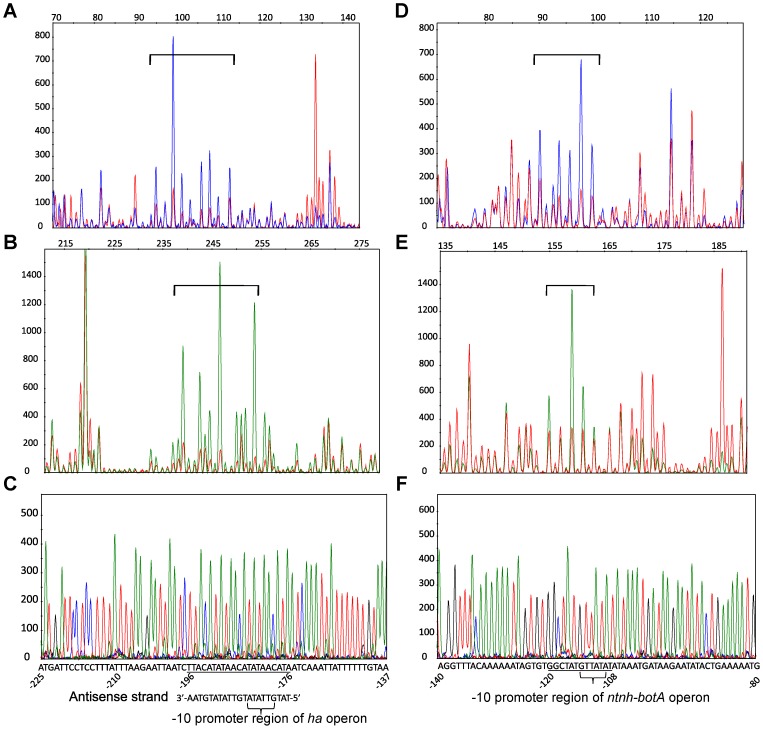
CBO0786 binds to the core promoter −10 region of the ha and ntnh-botA operons.DNase I footprinting analysis of 5′-6-FAM labeled sense strand (A, D) and 5′-HEX labeled antisense strand (B, E) of Pha33 probe (A, B) and Pntnh-botA probe (D, E). Comparison of DNase I digestion in the absence (blue peaks in A and D, green peaks in B and E) or with 10 µM of CBO0786 (red peaks). Protection regions are indicated by square brackets. Protection regions are underlined in sequencing electropherograms of Pha33 probe (C) and Pntnh-botA probe (F) in the sense strand. The consensus −10 regions of the ha and ntnh-botA promoters are indicated.